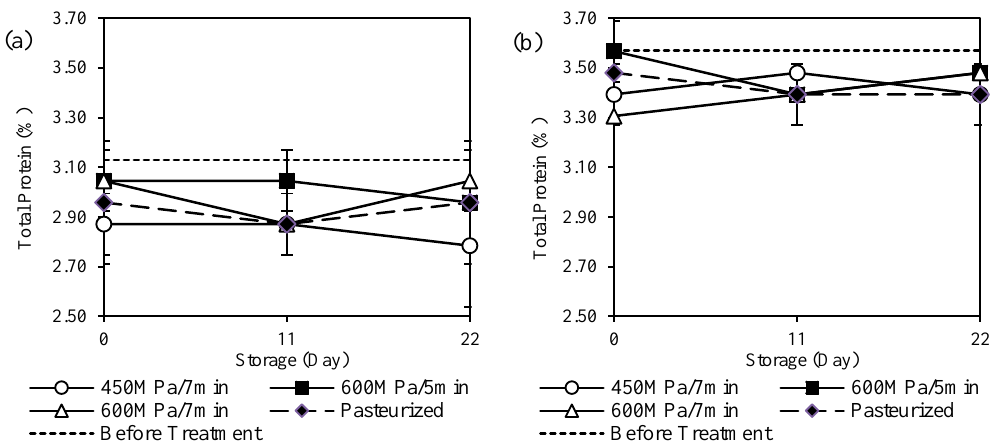
Figure 4. Changes in total protein of ( a ) cow and ( b ) goat milk during storage period of 22 days. Solid lines represent HPP-treated milk (450 MPa/7 min, 600 MPa/5 min, 600 MPa/7 min), dashed lines represent pasteurized milk and dotted lines represent fresh milk before treatment.